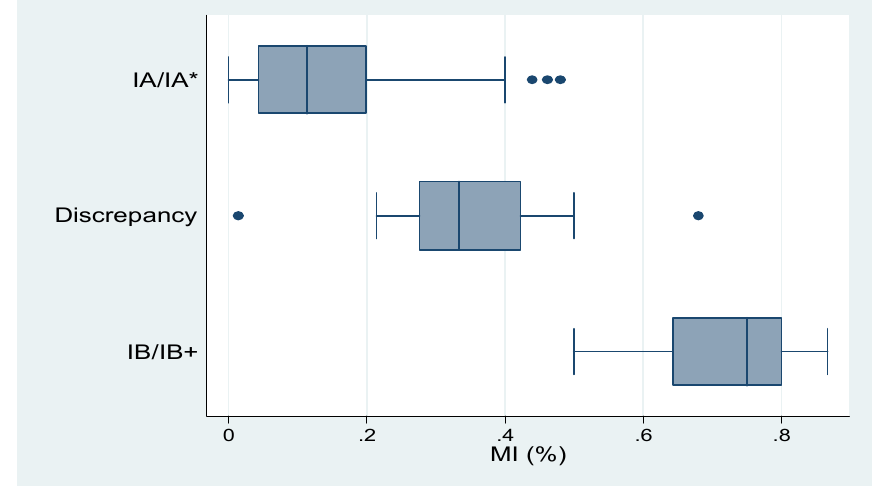
Figure 4. Box and Whisker Plot of data from radiologists′ diagnoses and pathological stages. Table 5. Results of AI interpretation and pathological stages (contrast-enhanced T1w and T2w).